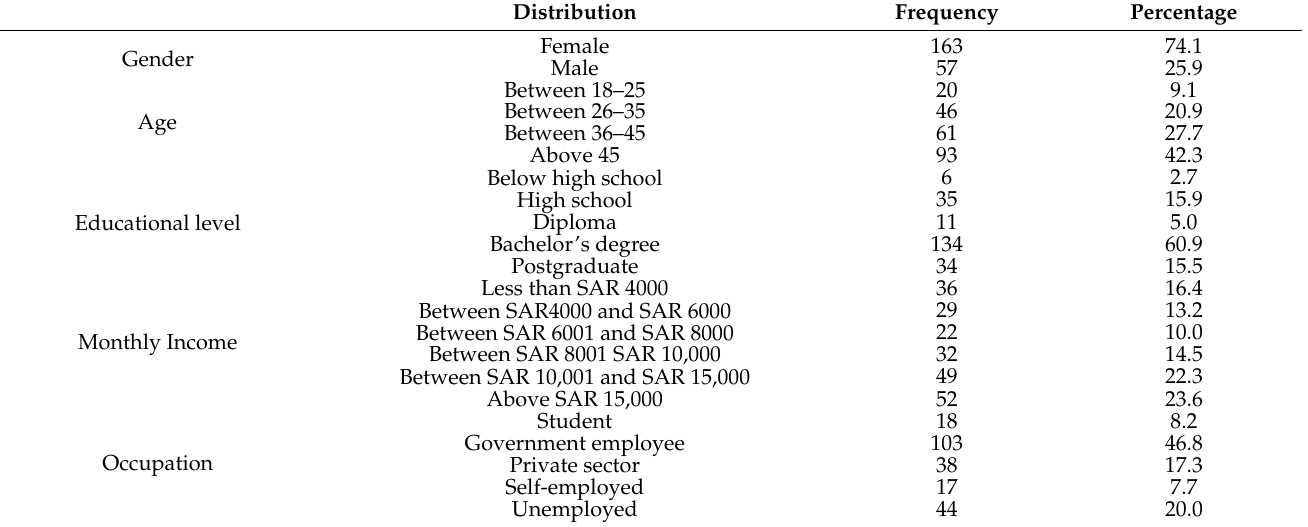
Table 1. Demographic information of the